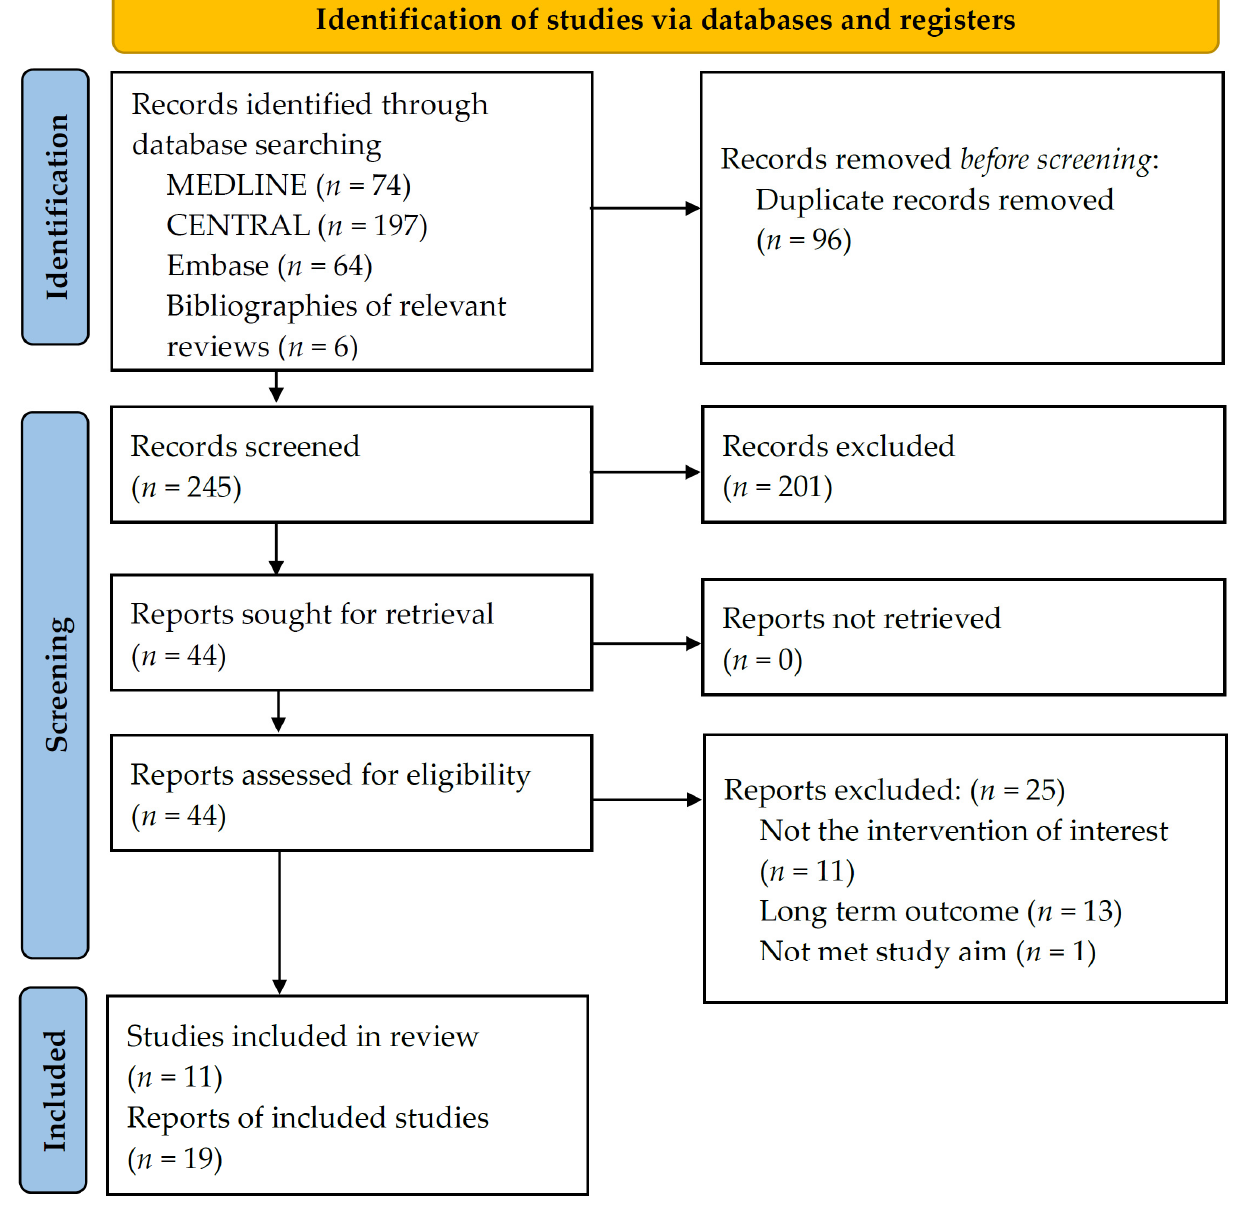
Figure 1. PRISMA study flow chart.